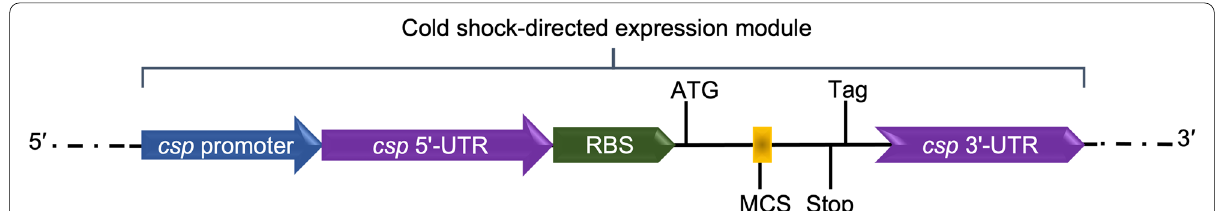
Fig. 3 Schematic representation of an expression module for a cold‑shock vector. Cold‑shock proteins (CSPs) are found in all organisms. The promoters of upregulated csp genes, ribosome binding site (RBS), and transcription terminator are the primary genetic elements regulating cold shock‑directed expression. The two former elements are sited on the upstream csp 5 ′ ‑end, whereas the third element is sited downstream on the csp 3 ′ ‑end. In addition to these genetic elements, the expression module must also contain the translation start codon (ATG), the multiple cloning sites (MCS), and the translation stop codon (Stop). Optionally, it can have some tags, such as the 6xHis tag, to facilitate the purification of recombinant proteins. csp 5 ′ ‑UTR: 5 ′ ‑untranslated region of csp , csp 3 ′ ‑UTR: 3 ′ ‑untranslated region of csp . Adapted from Bjerga and Williamson